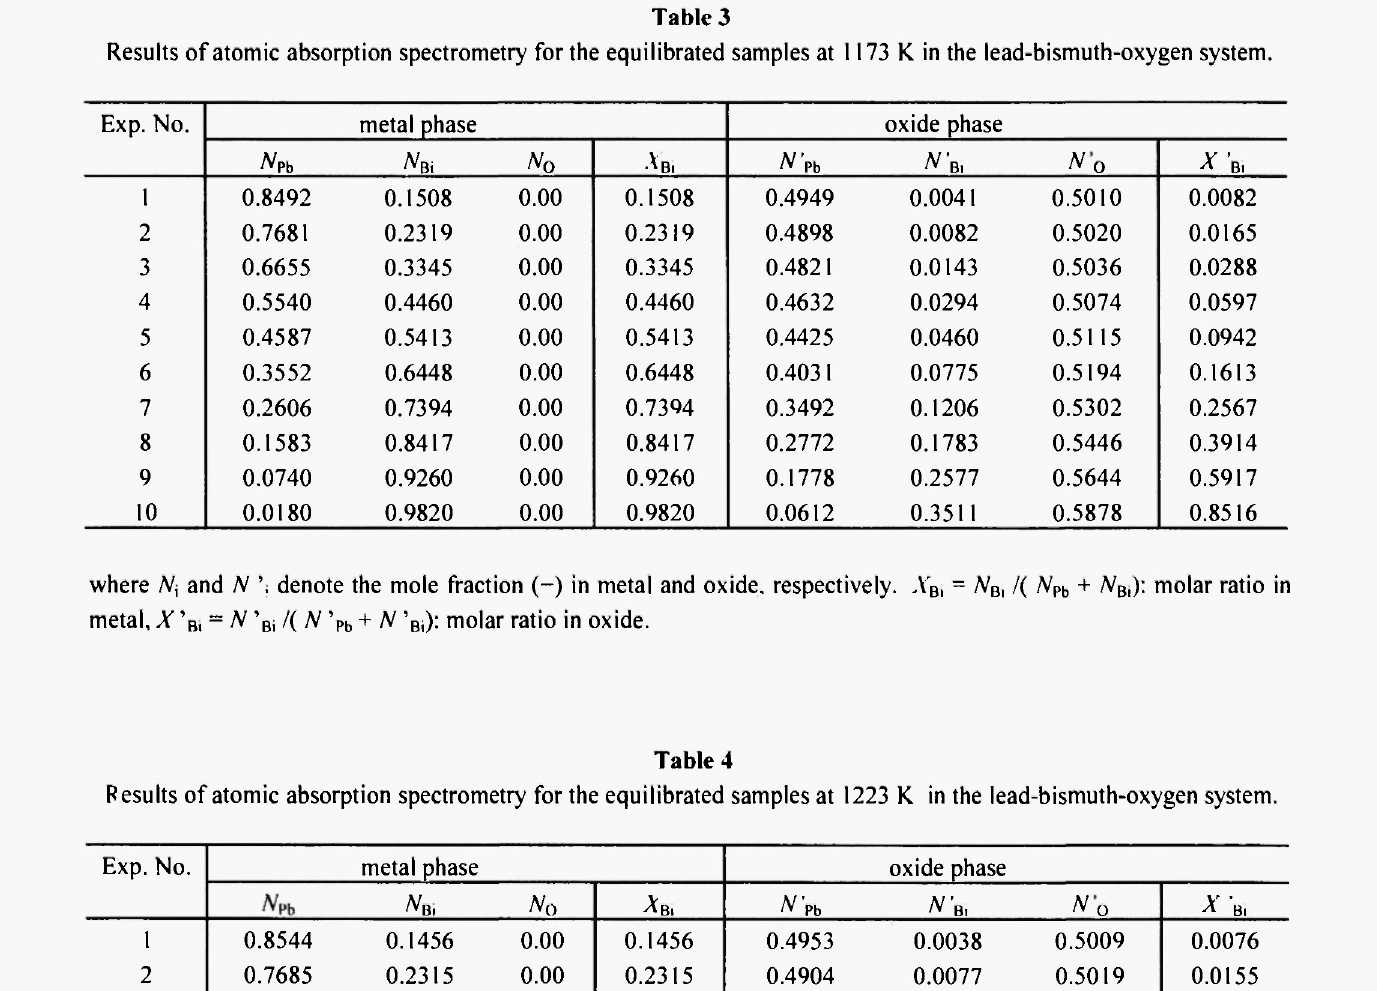
Results of atomic absorption spectrometry for the equilibrated samples at 1173 Κ in the lead-bismuth-oxygen system. Exp. No.